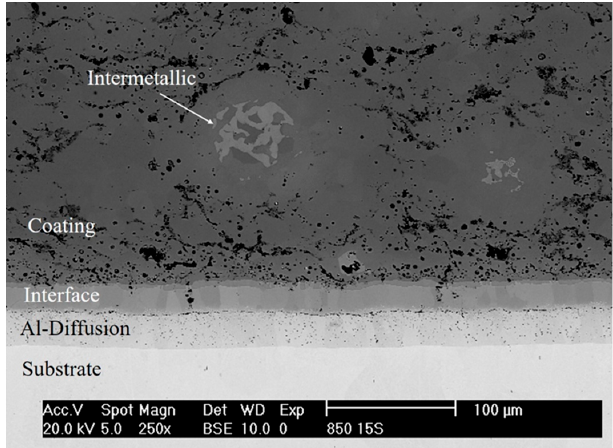
Figure 2. SEM image of a cross-section of the coating developed after reactive sintering on the AISI 304L stainless steel sample at a temperature of 850 °C, a pressure of 15 MPa, and time of 7200 s.